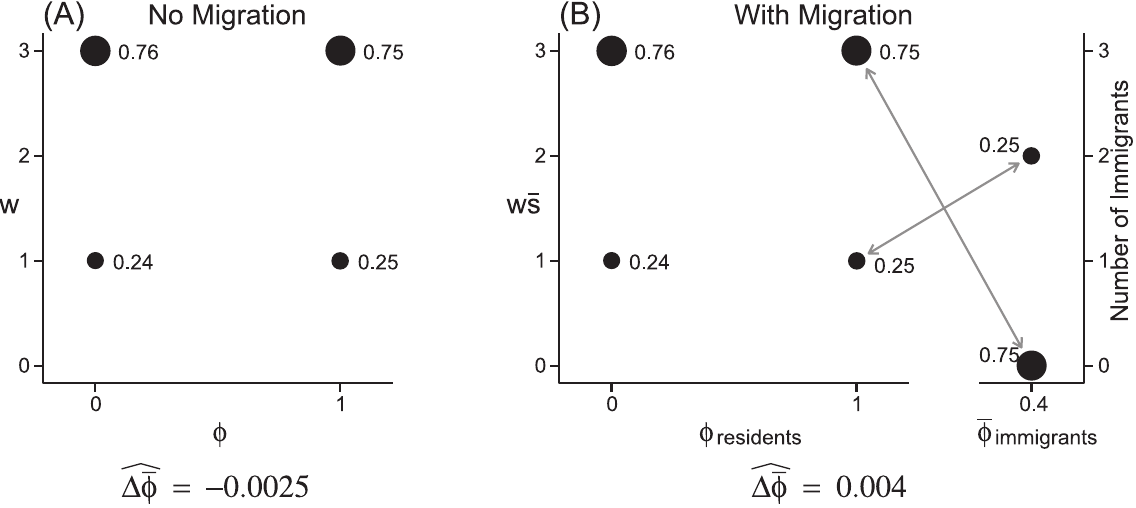
Figure 1. The consequences of a negative correlation between fitness and immigration rate. A) shows the fitness distributions for two phenotypes in a closed population. In the simple case of two individuals, one with w ~ 0 and one with w ~ 1 (so w ~ 0 : 5 ), the slightly higher expected fitness of w ~ 0 individuals causes the expected change in mean phenotype to be negative. B) shows the situation with variable immigration (and no emigration). Immigration rate is independent of the fitness of w ~ 0 individuals, but negatively correlated with the fitness of w ~ 1 individuals. Though the mean phenotype of immigrants is lower than the mean phenotype in the deme, and selection in the deme favors a lower phenotypic value, mean phenotype is expected to increase in this case because of the fact that w ~ 1 individuals do best at those times when low immigration leads to low deme growth rate. The same pattern holds in a deme of size N when w ~ 0 : 5 , individuals with a particular phenotypic value always do well or poorly together, and the number of immigrants fluctuates between 0 and N .